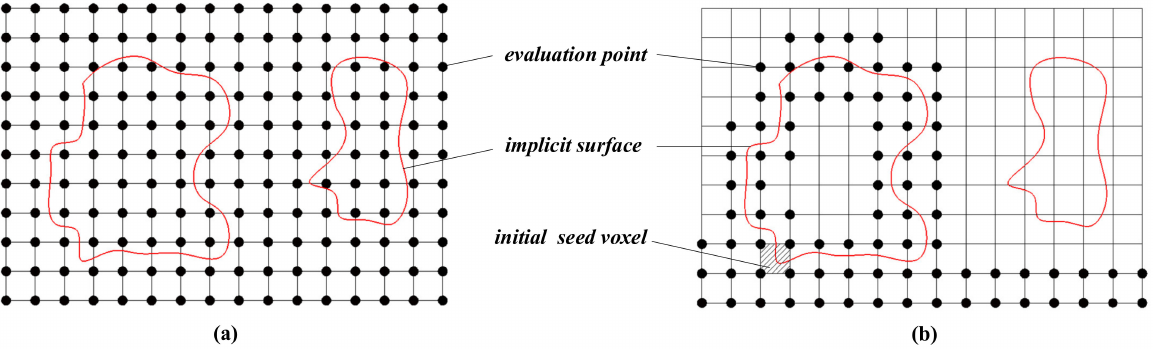
Figure 2. Comparison of evaluation points using different reconstruction methods. ( a ) The evaluation process using the marching cube method. ( b ) The evaluation process using the voxel growing method with one